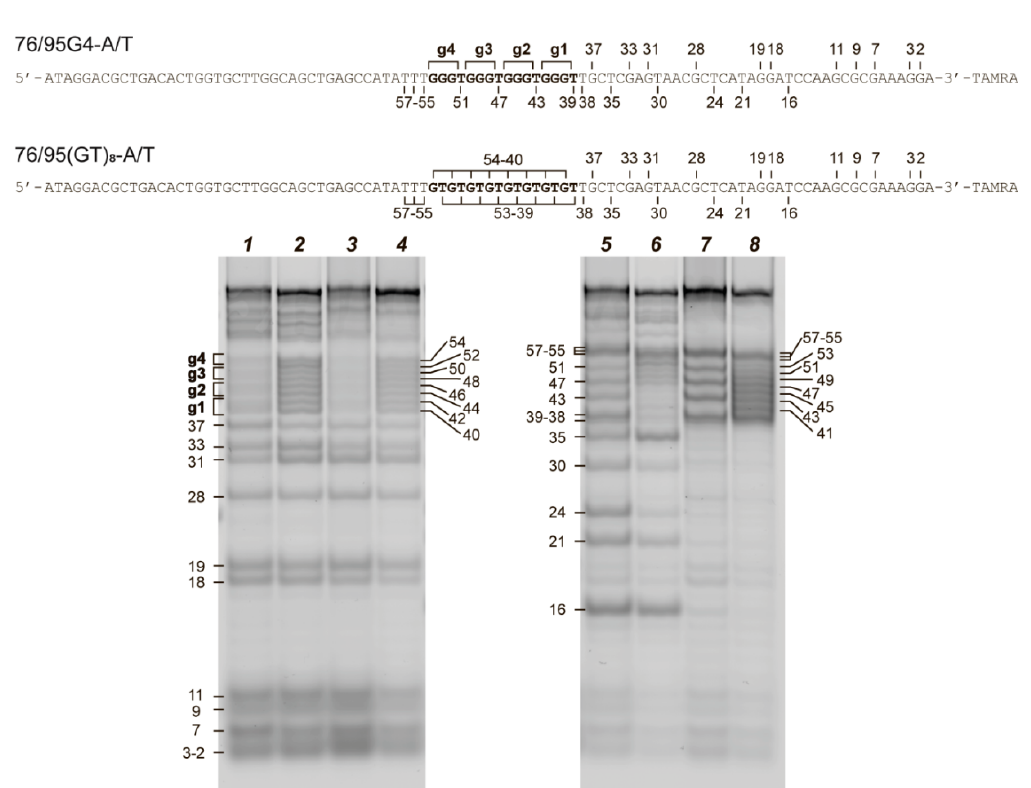
Figure 3. Chemical cleavage products of single- and double-stranded DNA models. A comparison of DMS (left panel) and KMnO 4 (right panel) cleavage patterns of oligonucleotides 95G4 (lanes 1 , 5 ) and 95(GT) 8 (lanes 2 , 6 ) as well as DNA duplexes 76/95G4-A/T (lanes 3 , 7 ) and 76/95(GT) 8 -A/T (lanes 4 , 8 ) labeled at the 3 ′ ends with the TAMRA fluorophore. The locations of G 3 tracts are indicated by the brackets on the left (left panel). The numbering of nucleotide units is indicated in sequences from 3 ′ to 5 ′ : left to right (two sequences at the top) and on left and right sides of electropherograms.